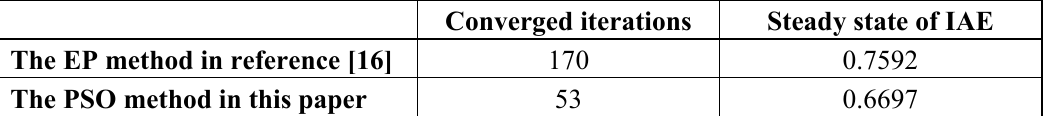
Table 1. The convergence situation of PSO vs . EP with the initial conditions